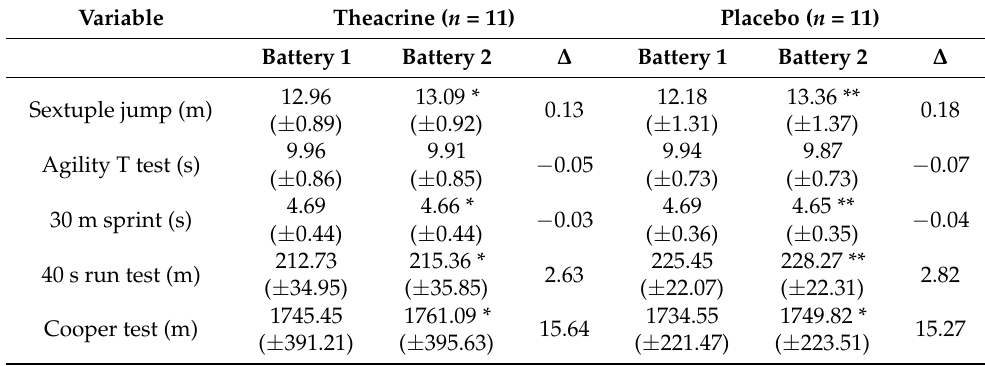
Table 2. Performance of the subjects in the physical tests in the first and second assessments.